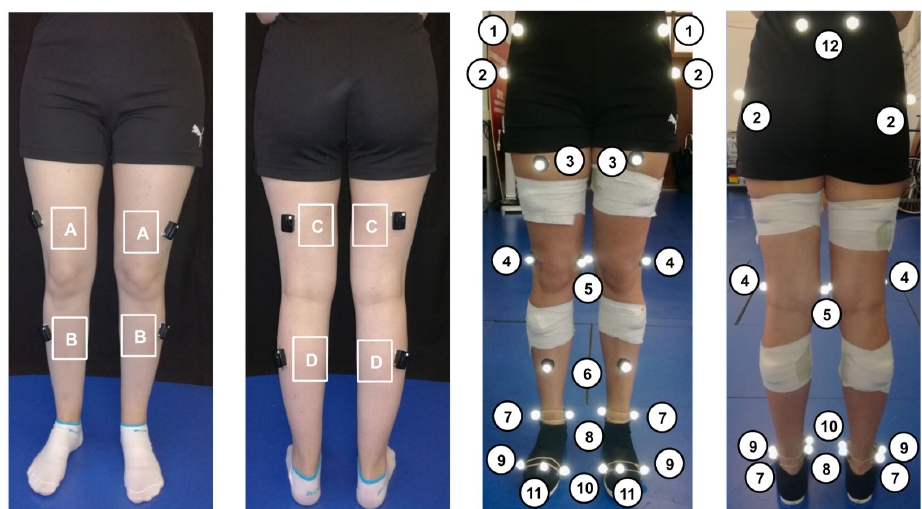
Figure 1. EMG configuration and marker ‐ set adopted: ( A ) VL; ( B ) TA; ( C ) BF; ( D ) GAL; (1) Anterior superior liiac apine; (2) trochanter; (3) thigh; (4) lateral knee; (5) medial knee; (6) shank; (7) lateral ankle; (8) medial ankle; (9) foot metatarsal 5; (10) foot metatarsal 1; (11) foot metatarsal 2; (12) posterior superior iliac spine.